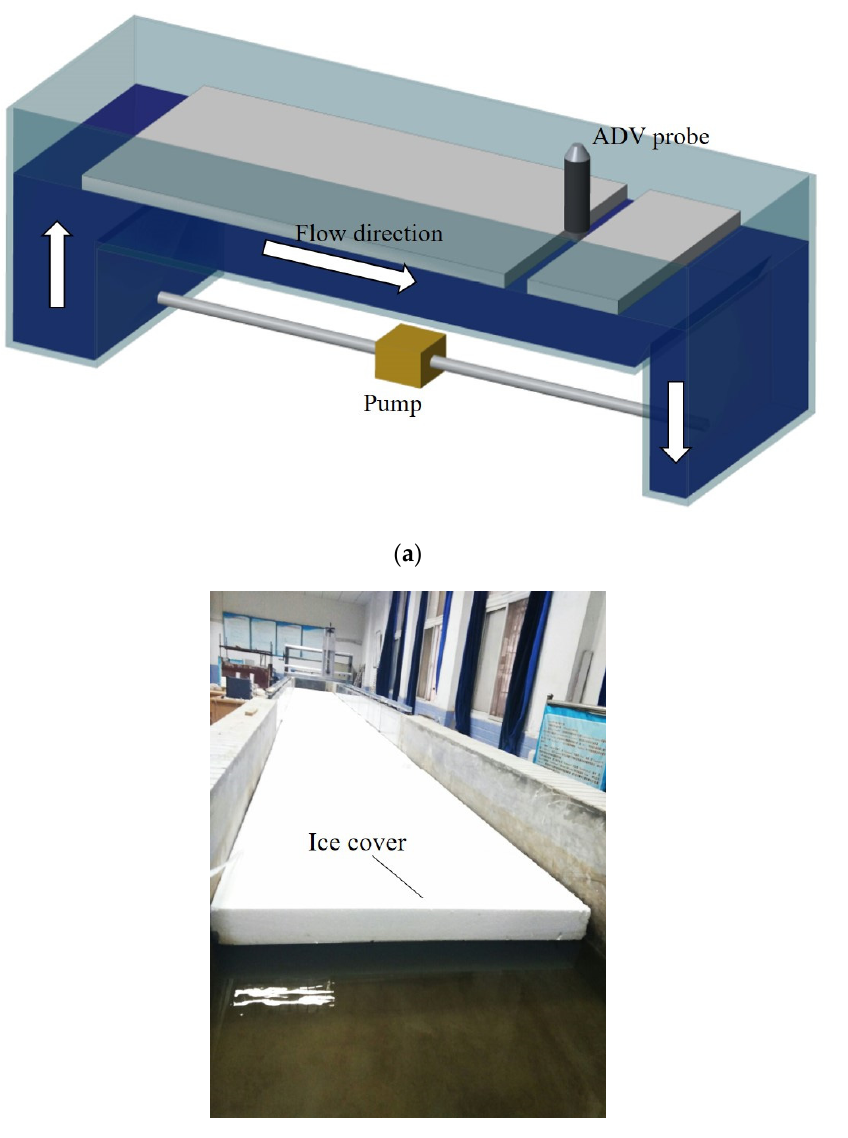
Figure 2. ( a ) Schematic of the experimental flume, the dark blue denoting the flow in the flume and ( b ) images of the experimental site.